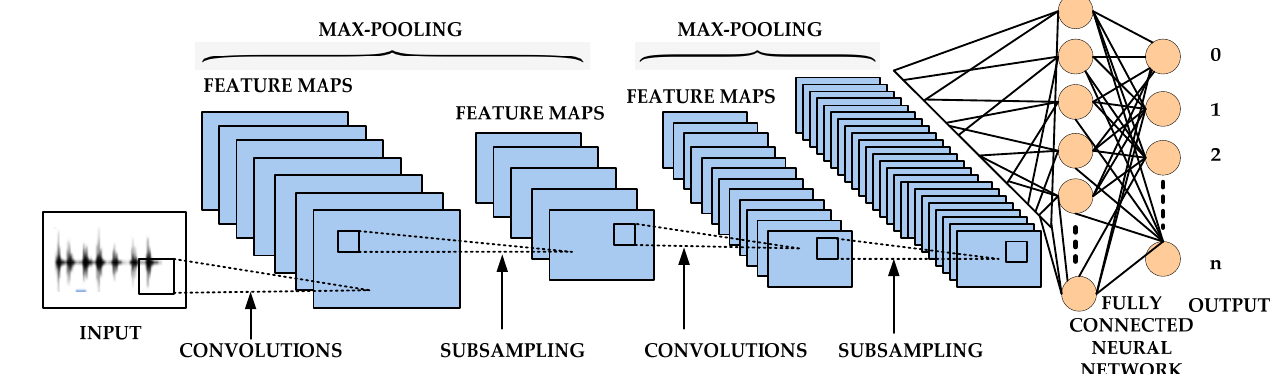
Figure 7. Representation of deep learning model using CNN and ANN.